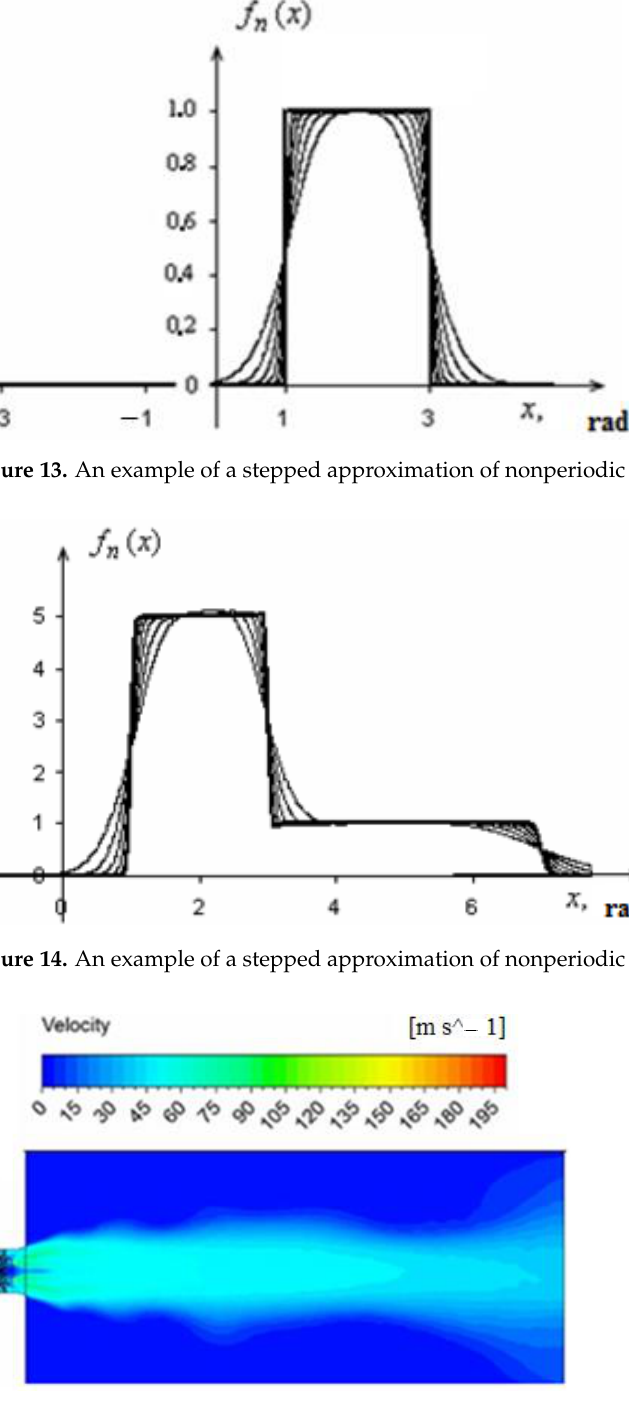
Figure 15. Presentation of the results of physical modeling of the dependence of the torch length on the amount of air for a rotating furnace (according to the authors’ data). the amount of air for a rotating furnace (according to the authors’